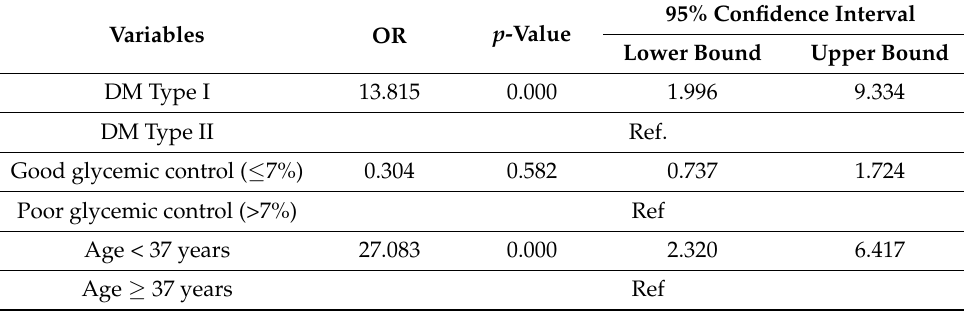
Table 4. Predictors of periodontal diseases using multivariate logistic regression